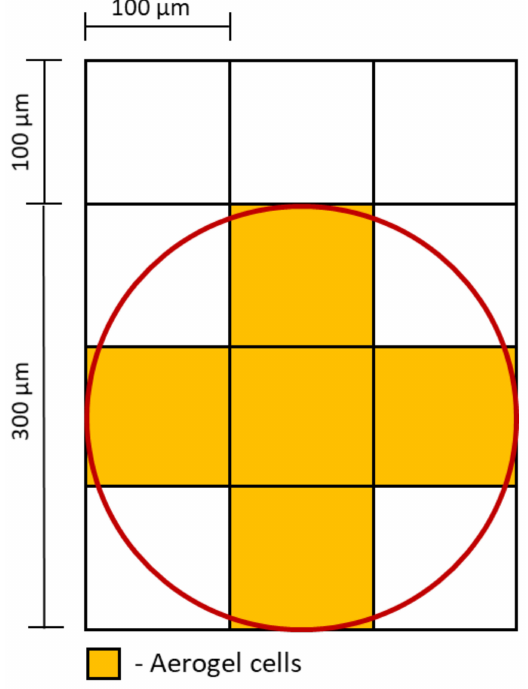
Figure 12. Aerogel particle digital copy with a diameter of 300 µ m, considering the scale of the model. The red circle corresponds to the shape of real aerogel particle.